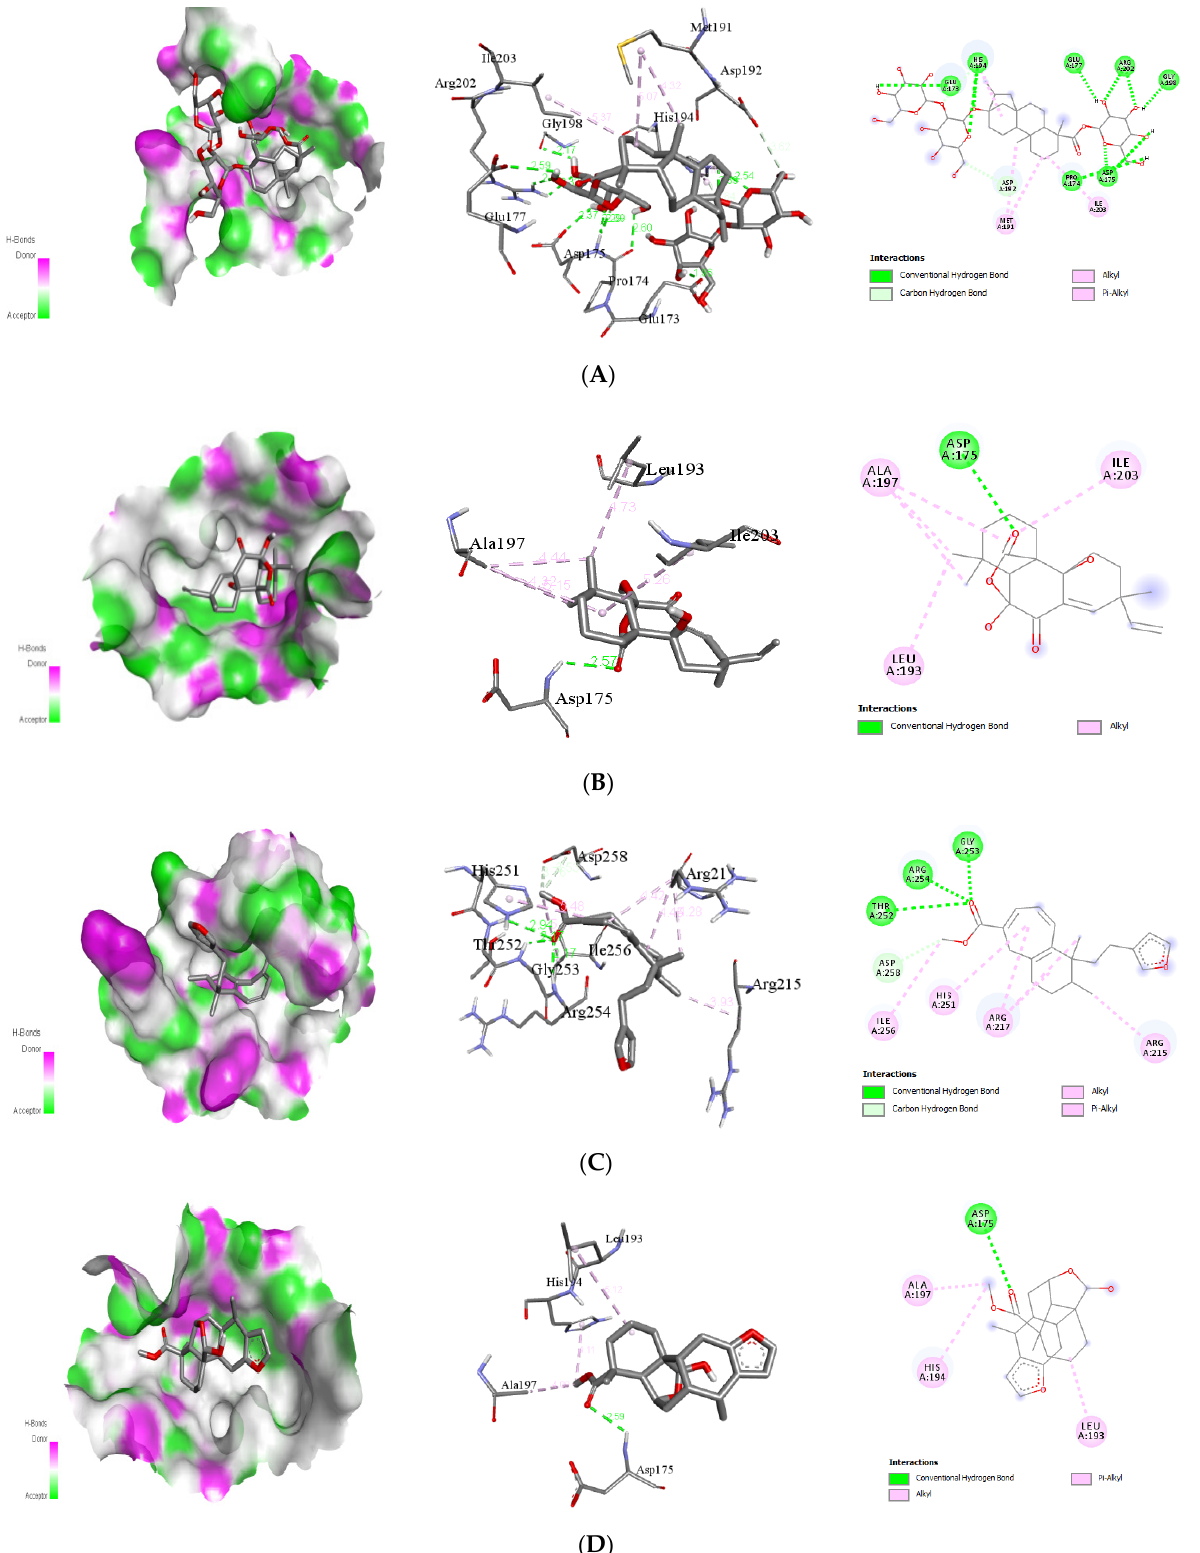
Figure 4. Binding poses of four top-ranked compounds at the binding site of dengue viral NS3 (PDB ID: 2VBC) and 2D and 3D interaction diagrams. ( A ) Stevioside-NS3; ( B )sphaeropsidin A-NS3; ( C ) methyl dodovisate A-NS3, and ( D ) caesalacetal-NS3.